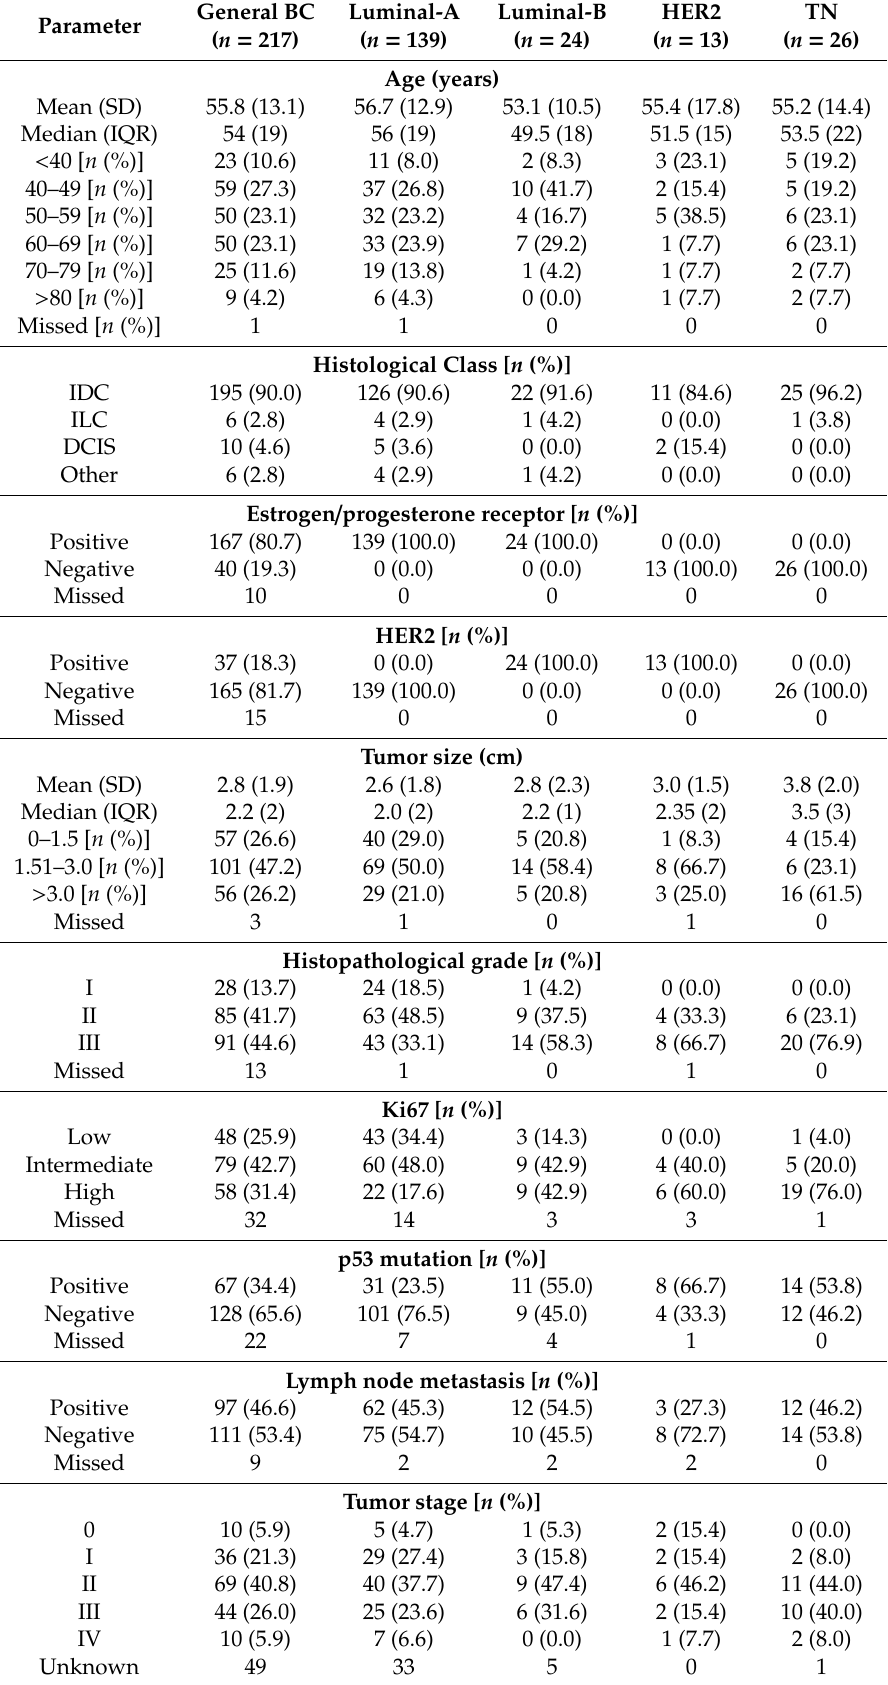
Table 1. Patients’ clinicopathological